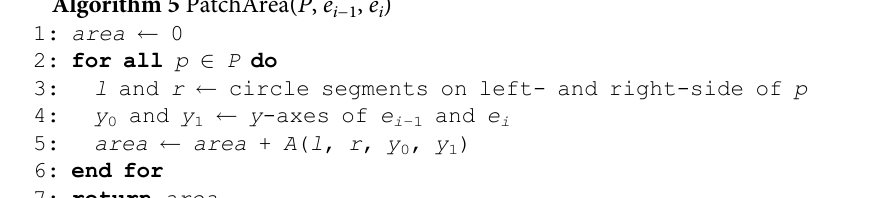
Algorithm 5 PatchArea( P , e